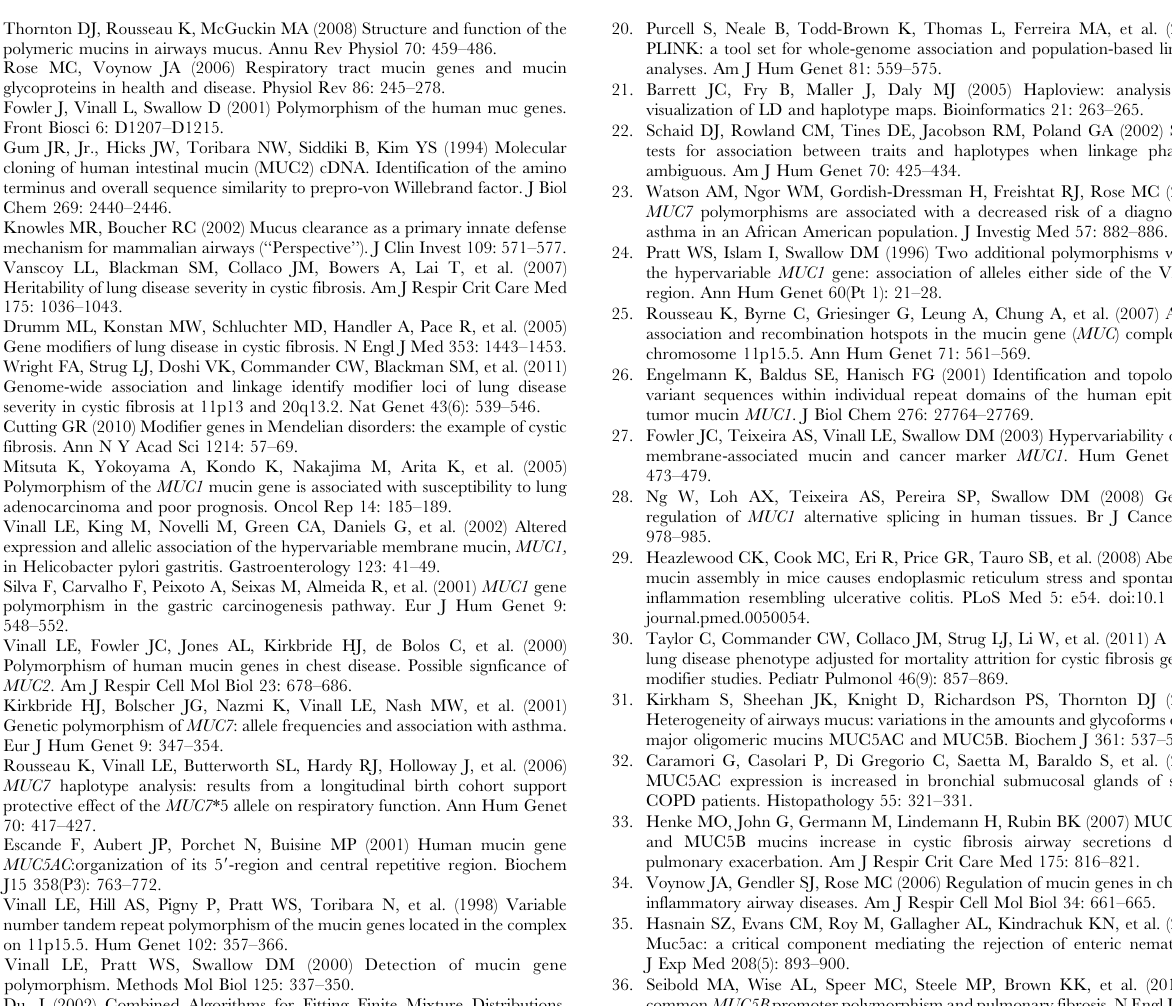
Table S2 Association of MUC1 and MUC2 VNTR allele sizes with lung disease severity. Table S3 Association of MUC1 , MUC2 and MUC5AC SNPs with CF lung phenotype. Table S4 Two-variant haplotype analysis for 6.3